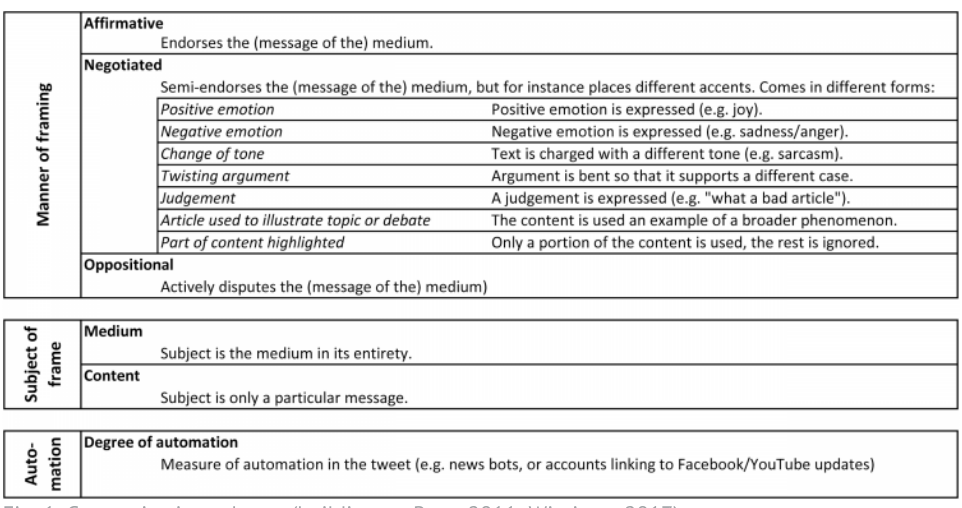
Fig. 1. Categorisation scheme (building on Ross, 2011; Wieringa,